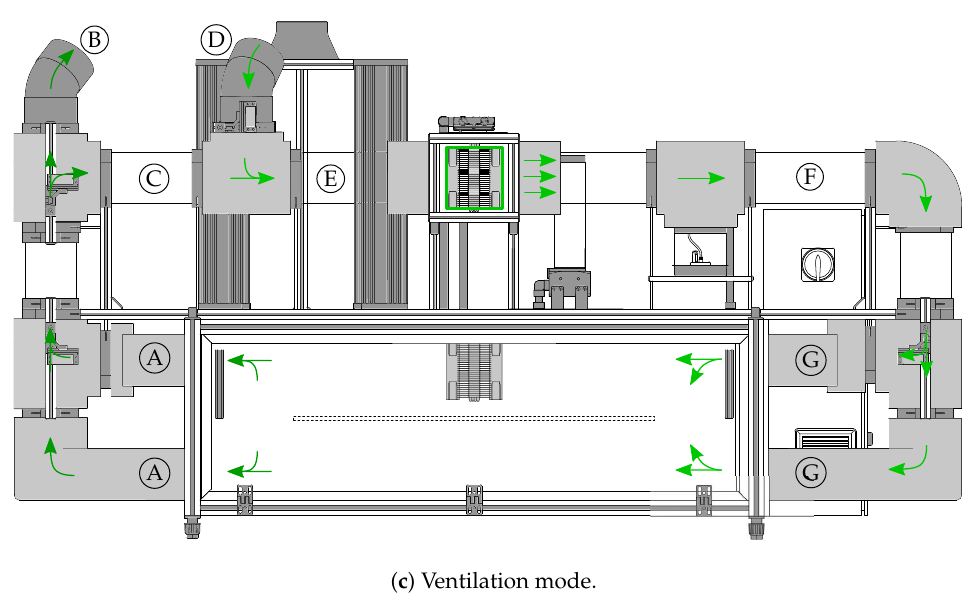
( c ) Ventilation mode. Figure 5. Illustration of the air flow within the laboratory HVAC system in various operation modes. Figure 5. Illustration of the air flow (coloured arrows) within the laboratory HVAC system in various operation modes. Note: The circled letters relate to designation of particular air types in Table